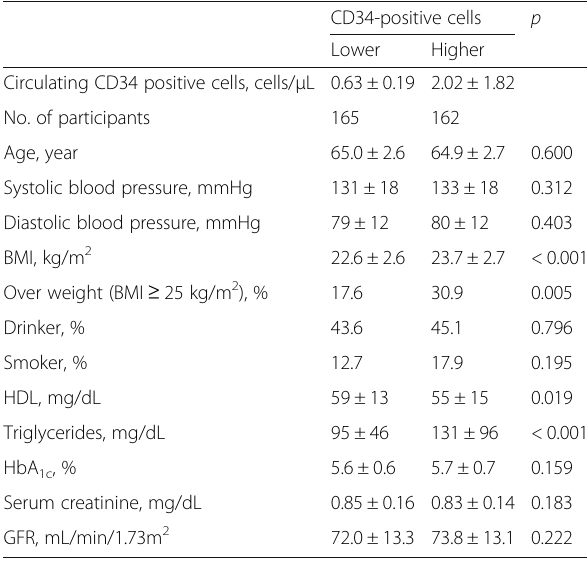
Table 1 Characteristics of the study population based on levels of circulating CD34-positive cells CD34-positive cells